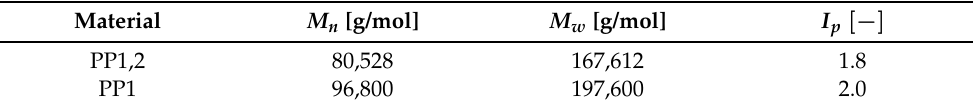
Table 2. Molar mass, polydispersity index and activation energy of PPs under